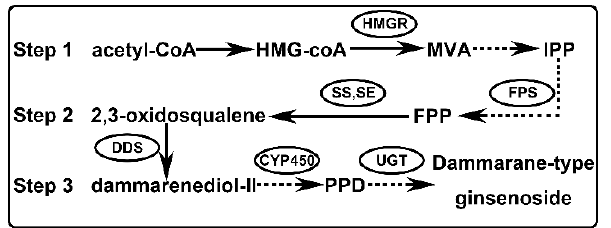
Figure 1. Biosynthetic pathway map of dammarane-type ginsenoside in P. ginseng . FPP: farnesyl pyrophosphate; PPD: protopanaxadiol.